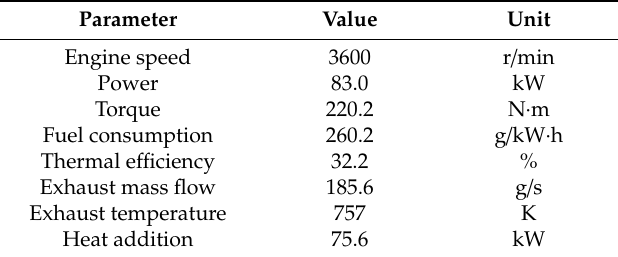
Table 4. The engine performance under the rated power